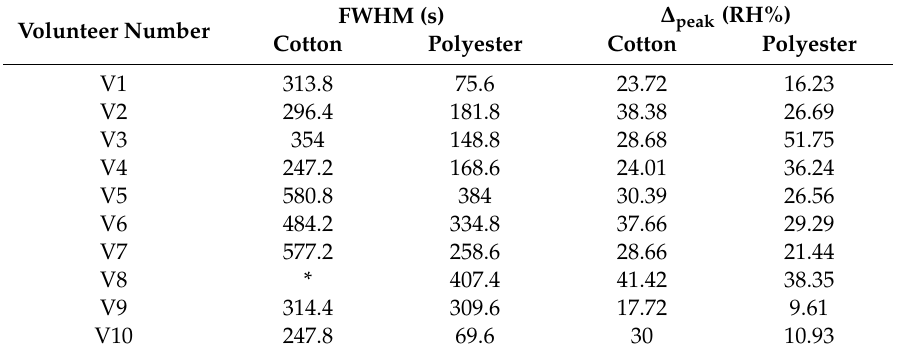
Table 1. Full width at half maximum (FWHM) and ∆ peak of the OFHS RH reading under di ff erent textile (100% cotton and 100% polyester) for 10